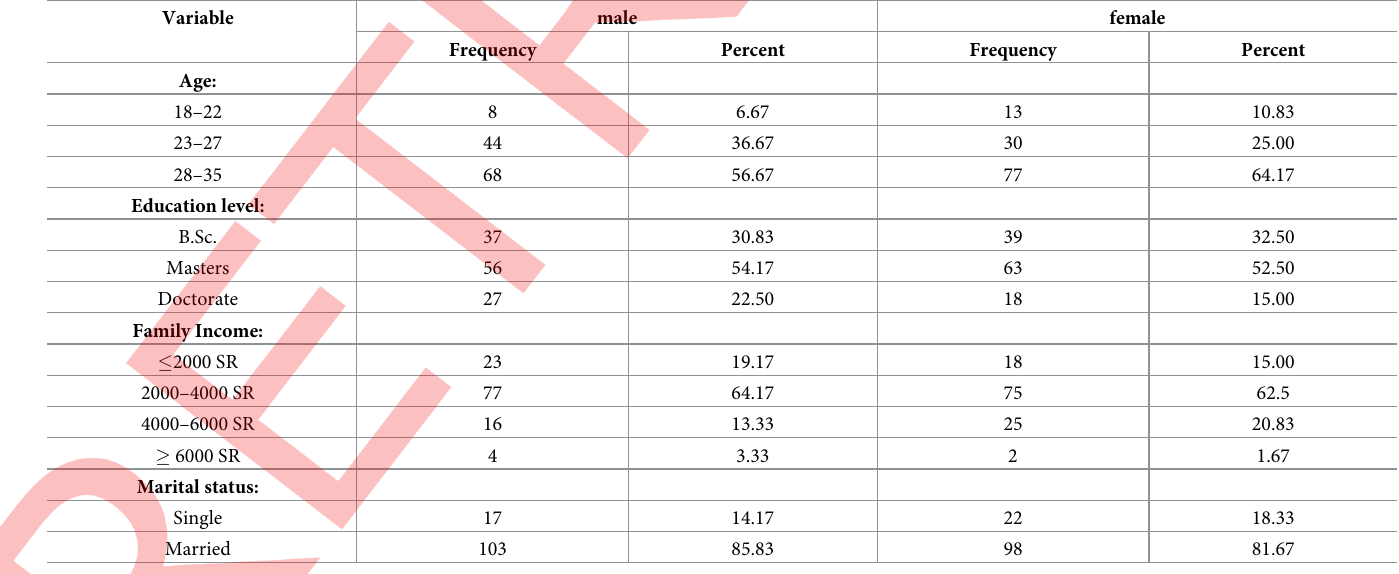
Table 1. Frequency distribution of Yemeni male and female students according to socioeconomic data.